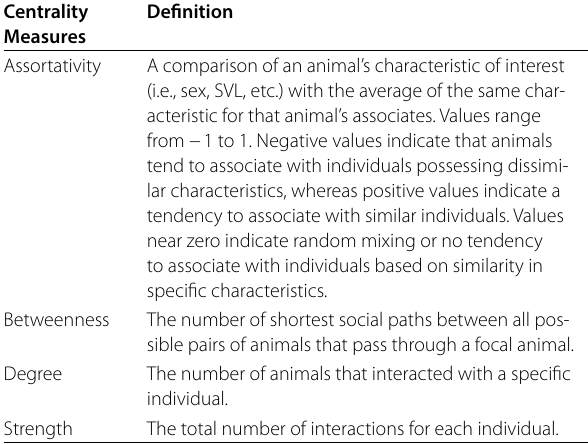
Table 2 Definitions for network measures of centrality Centrality